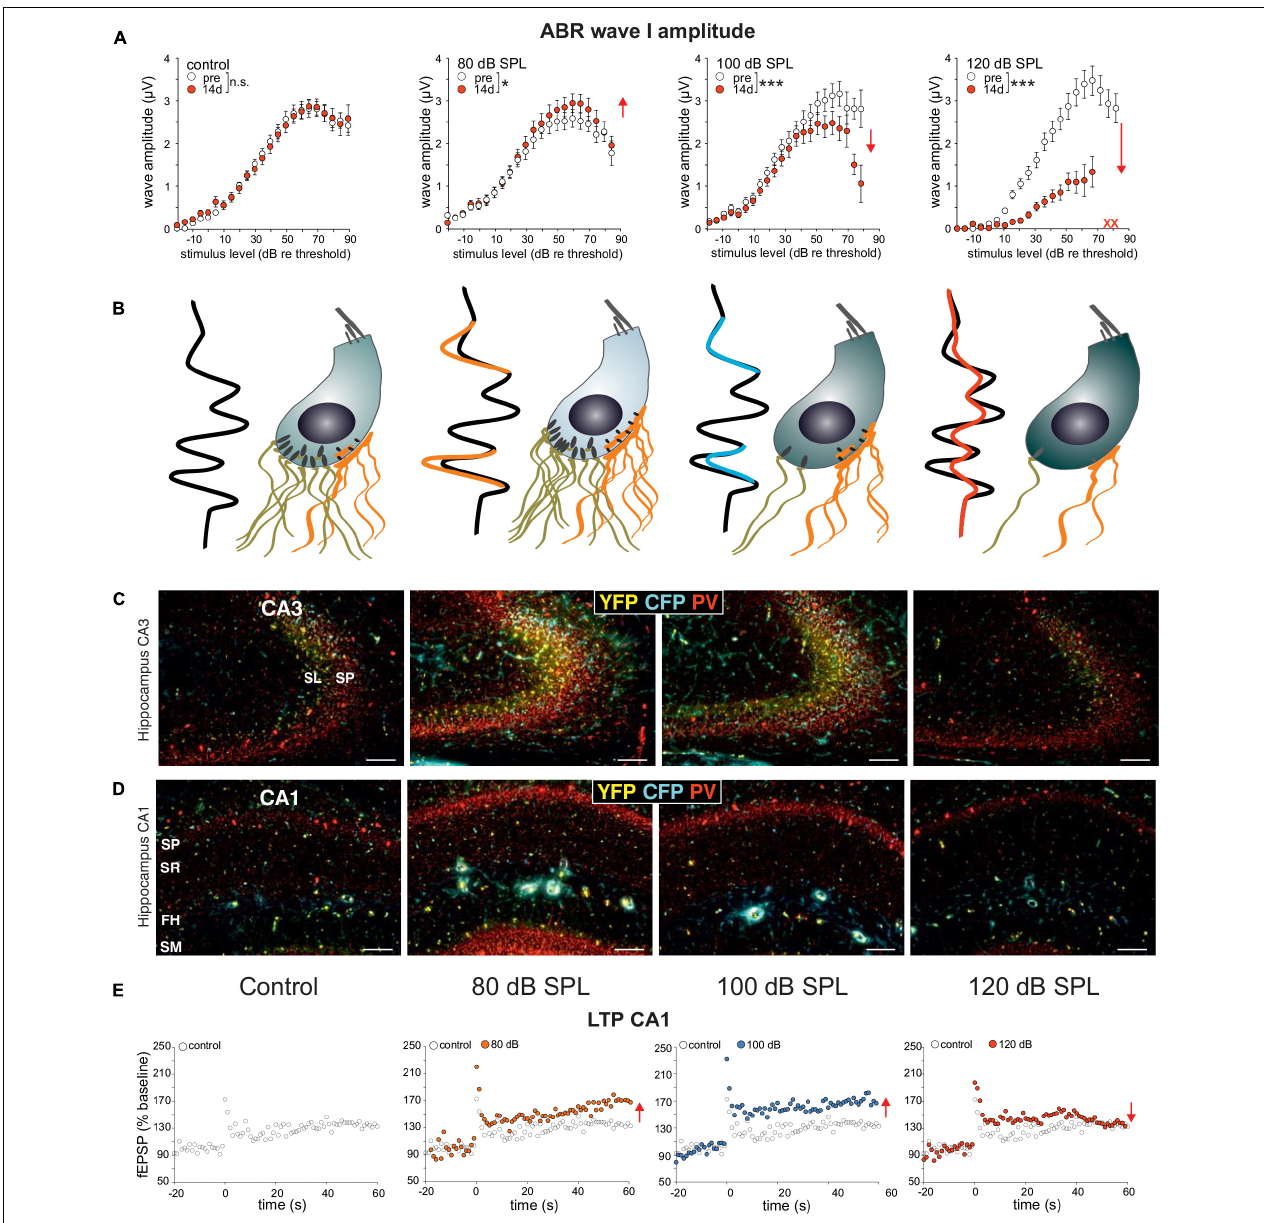
FIGURE 4 | (A) ABR wave I responses are enhanced after sound exposure of 80 dB SPL and reduced after 100 dB SPL stimulation which can be compensated on the level of the ABR wave IV (see B ), while ABR wave I amplitudes decrease after 120 dB SPL exposure. (B) ABR wave I amplitude changes are linked to changes in IHC ribbons that are mostly preserved after sound enrichment (80 dB SPL), but decline following mild acoustic trauma (100 dB SPL). In contrast, following severe stressful acoustic trauma (120 dB SPL), ribbon loss exceeds 50%, pointing to a loss of high-SR auditory fibers. (C,D) This goes along with marked increases in PV (red), Bdnf exon IV transcripts in capillaries (cyan), and exon VI transcripts in nerve endings (yellow), as can be observed in hippocampal CA3 (C) and CA1 (D) regions following 80 and 100 dB SPL, but not following 120 dB SPL exposure (Matt et al., 2018). (E) Significantly increased LTP observed after 80 dB SPL and 100 dB SPL, but not after 120 dB SPL sound exposure compared to that of the controls. Scale bars in (B,C) indicate 100 µ m. Modified after Matt et al. (2018). SP, stratum pyramidale; SR, stratum radiatum; FH, fissura hippocampi; SM, stratum moleculare; SL, stratum